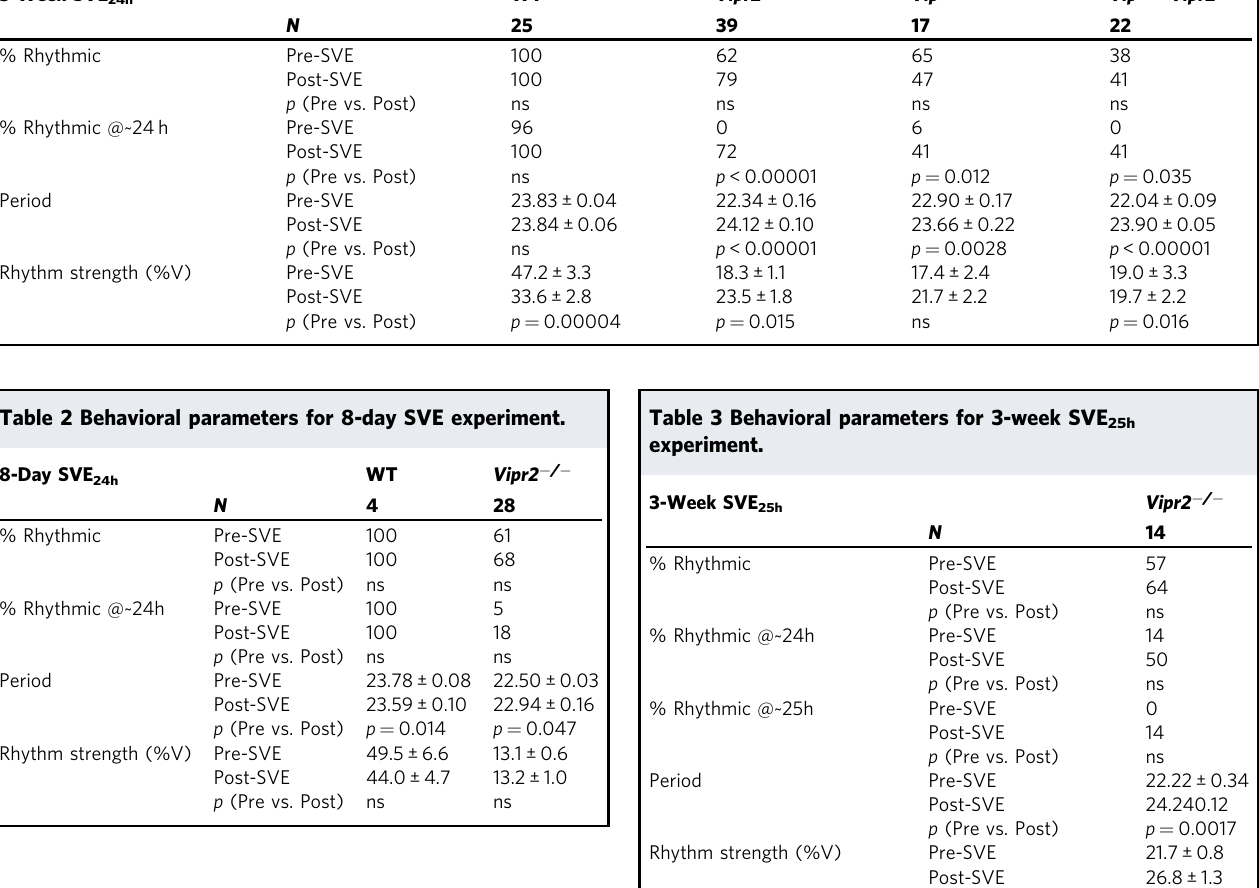
Fig. 2 Neuropeptide signaling-de fi cient mice show dose-dependent responses to SVE but do not typically express ~25 h rhythms following an SVE Zeitgeber with a 25 h period. a Representative double-plotted actograms showing locomotor activity (black) and drinking activity (blue) for WT and Vipr2 − / − mice ( n = 4 and 28, respectively) undergoing an 8-day 24 h SVE protocol. Shaded areas represent darkness. Red boxes indicate time of wheel availability during SVE (6 h). b Dot plot overlaid on box plot depicts the period of wheel-running activity, while bar charts show the percentage of mice rhythmic (in total) and percentage of mice rhythmic with ~24 h period pre- and post-SVE. Gray shaded boxes represent the interquartile distance between the upper and lower quartile with the median plotted as a horizontal line within the box. Whiskers in b depict the lower quartile − 1.5 × interquartile distance and upper quartile + 1.5 × interquartile distance, while the individual data point symbols show only points that contributed to statistical assessment (only individuals rhythmic both pre- and post-SVE were included in paired t tests due to the requirements of this repeated-measures assessment; n = 4 of 4 WT, 17 of 28 Vipr2 − / − ). A version of this panel showing all data points pre- and post-SVE can be seen in Fig. S2c. Bar/dot shading for upper and middle panels of b is as shown in the lower panel. The increase from 4 to 18% of the Vipr2 − / − population ( n = 28 total) expressing ~24 h rhythms following 8 days of SVE is not signi fi cant. However, the mean period of post-8-day SVE Vipr2 − / − mice was signi fi cantly lengthened (22.94 ± 0.16 h post-SVE vs. 22.5 ± 0.03 h pre-SVE; p = 0.023; paired t test). * p = 0.023. Post 8-day SVE, WT behavioral period was signi fi cantly shorter than pre-8-day SVE, which represents the typical shortening of period associated with continued free run in constant darkness and is not a result of 8-day SVE (see Table 1). c Representative double-plotted actograms showing locomotor activity (black) and drinking activity (blue) for Vipr2 − / − mice ( n = 8) undergoing a 1 h per day SVE protocol (SVE 1h ). Shaded areas represent darkness. Red boxes indicate time of wheel availability during SVE (1 h). One individual exhibited robust ~24h rhythms in behavior after 1 h/day of SVE for 21 days, but the remaining 7 individuals failed to express clearly identi fi able rhythms. See also Table 1. d Representative double-plotted actograms showing locomotor activity (black) and drinking activity (blue) for Vipr2 − / − mice ( n = 14) undergoing a 25 h SVE protocol (SVE 25h ). Here the animals have the opportunity to voluntarily exercise in the running wheel for 6 h every 25 h. Shaded areas represent darkness. Red boxes indicate time of wheel availability during SVE. e Chi 2 periodograms showing dominant circadian period of running-wheel activity both pre-SVE 25h (pink/light) and post SVE 25h (red/dark). Diagonal broken lines indicate signi fi cance threshold at p = 0.0001. Vertical blue lines indicate 24 h period for visual reference. f Bar chart showing percentages of mice rhythmic (in total), rhythmic with ~24 h period, and rhythmic with ~25 h period, pre- and post-SVE 25h . Few Vipr2 − / − mice express ~25h period behavioral rhythms post-SVE 25h , with most mice that are rhythmic expressing ~24 h rhythms in behavior. Also see Table 1.